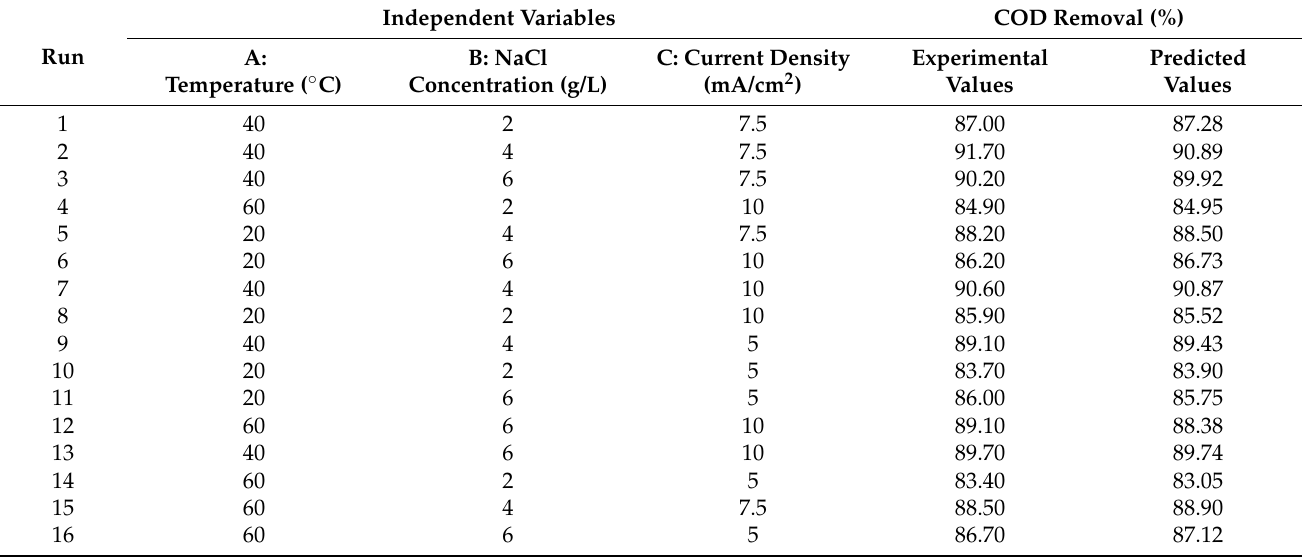
Table 2. Box-Behnken Design output (responses)